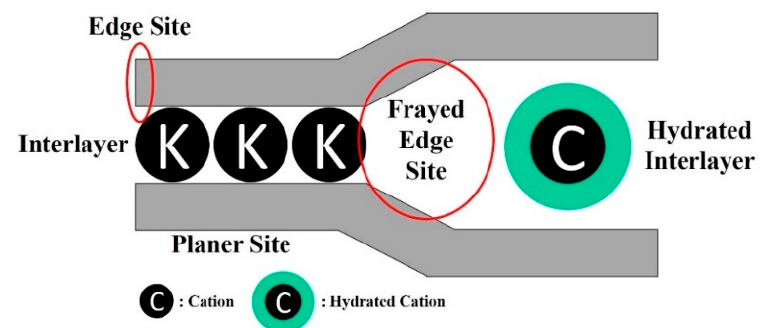
Figure 6. Illustrative representation of the Cs + adsorption positions on 2:1 phyllosilicates. Reprinted with permission from reference [100].